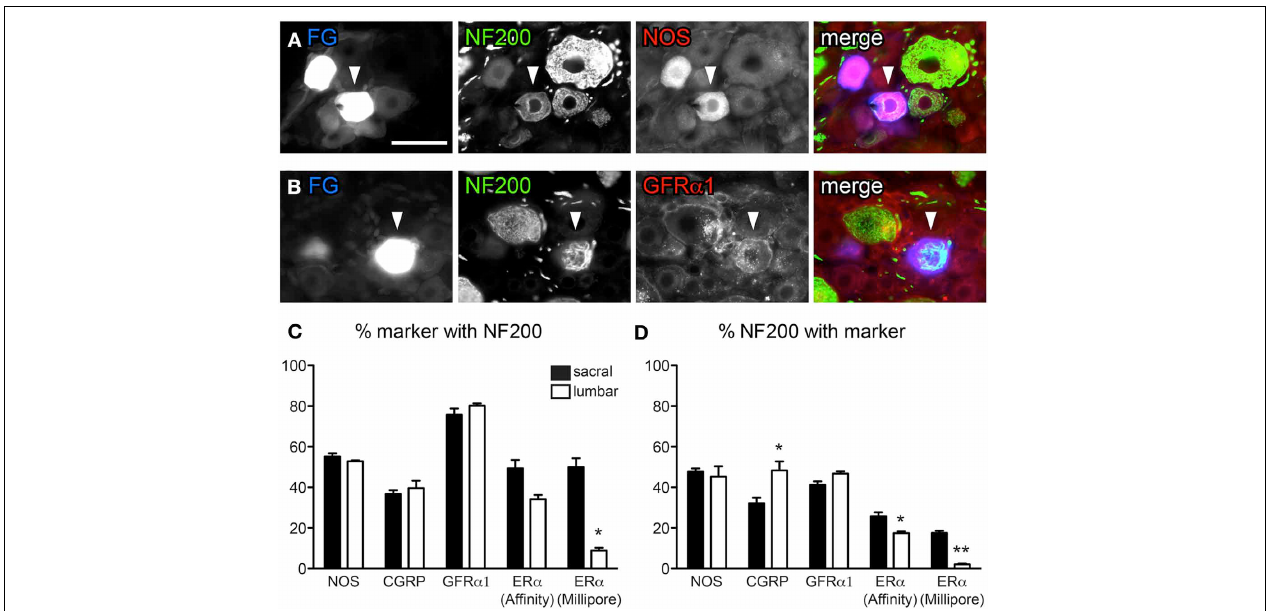
FIGURE 3 | Distribution of NF200-immunoreactivity (IR) in bladder sensory neurons. Data shown here compares two antibodies raised against ER α , purchased from either Affinity Bioreagents or Millipore. (A, B) Co-expression of NF200 with NOS (A) and GFR α 1 (B) in bladder-projecting neurons retrogradely labeled with FluoroGold (FG). The neurons in panel (B) are from the same field of view as Figure 1F . Images are shown as monochrome image sets and the merged image. The color of each label in the merged image is indicated by the color of the text in the relevant monochrome image. Scale bar in panel (A) represents 50 μ m and applies to all images. (C) The proportion of NOS-,